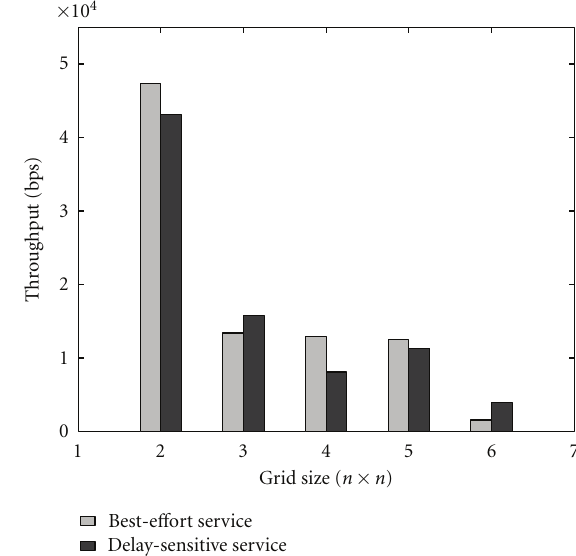
Figure 11: Throughput comparison: delay sensitive versus best ef- fort.